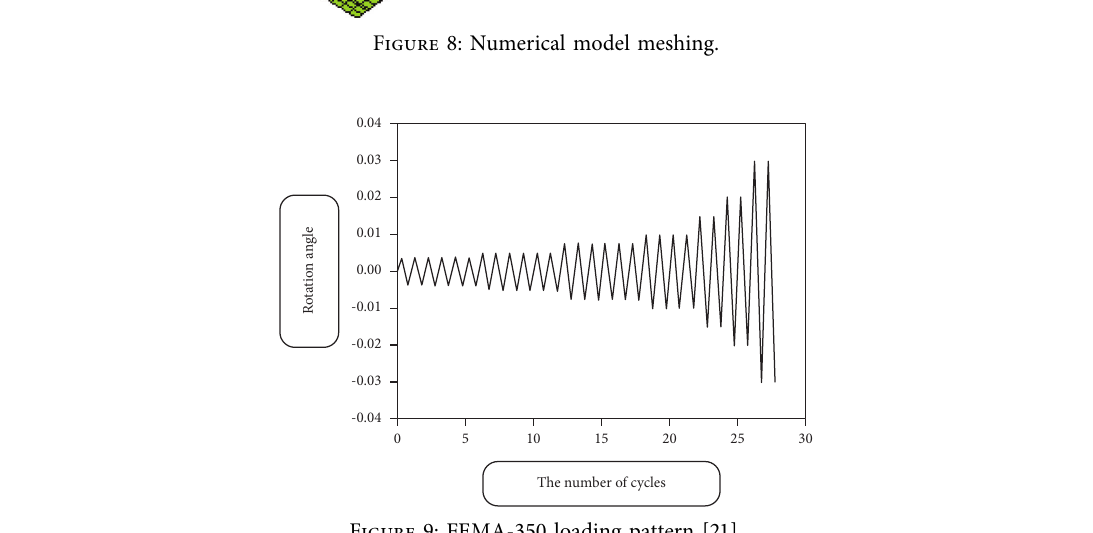
Figure 9: FEMA-350 loading pattern [21].